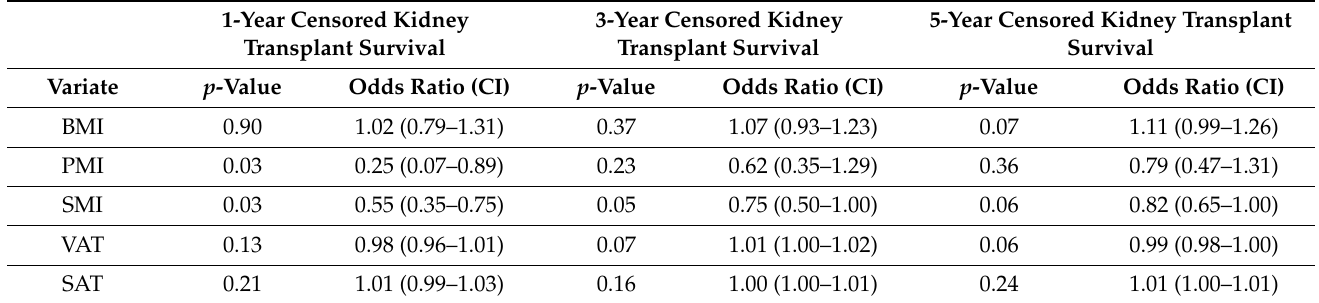
Table 4. Cox regression analysis of 1-year, 3-year and 5-year censored kidney transplant survival with the variates BMI and AI-derived body composition parameters PMI, SMI, VAT, and SAT.